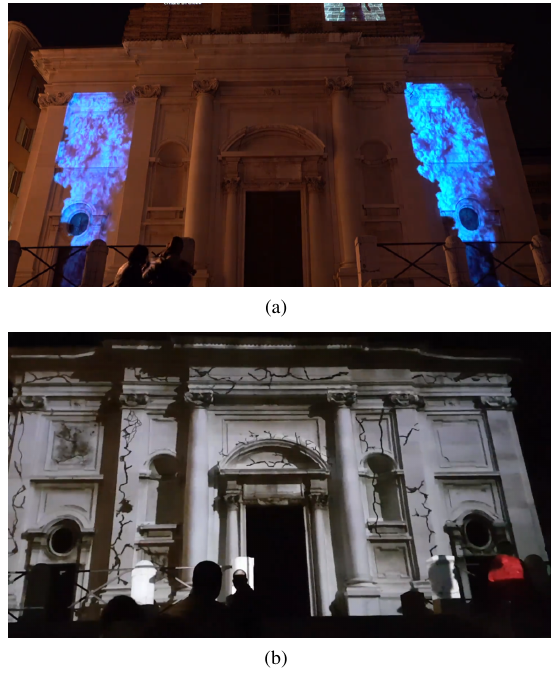
Figure 5. Two examples of storytelling on the fac¸ade: Paint my ark Sharper 2018 (a), Dorian Sharper 2017 (b).